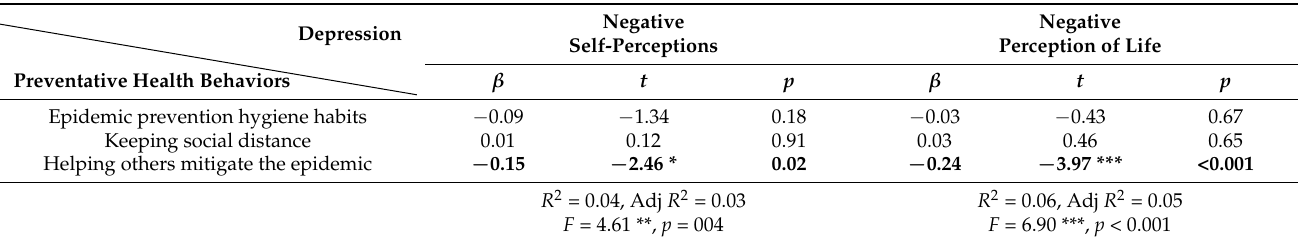
Table 4. Linear regression of COVID-19 preventative health behaviors against